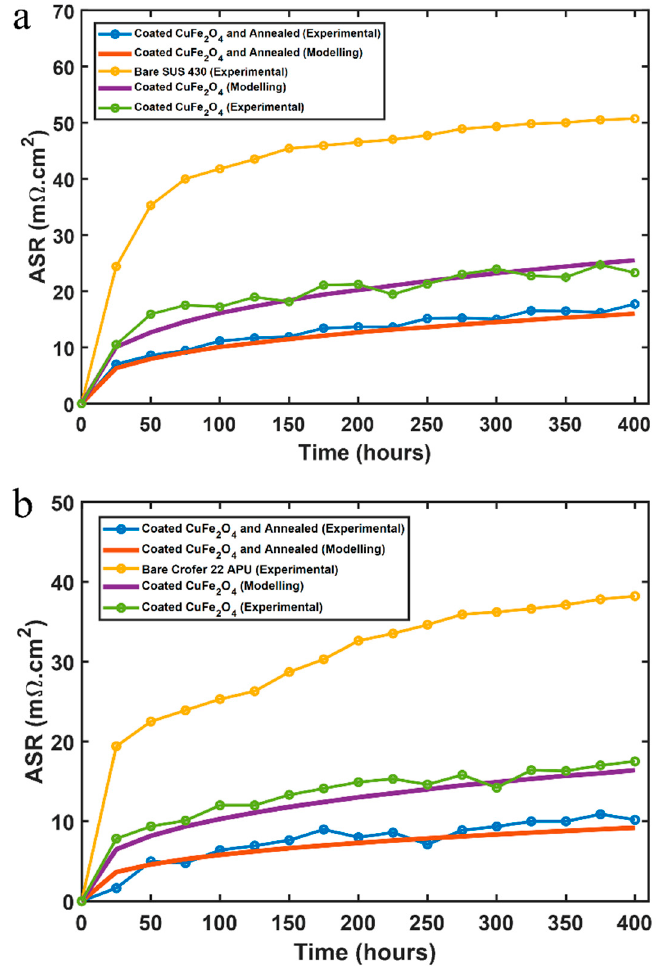
Figure 8. Comparison of experimental and modeling data in a coated and annealed sample of ( a ) SUS 430 and ( b ) Crofer 22APU. 430 and ( b ) Crofer